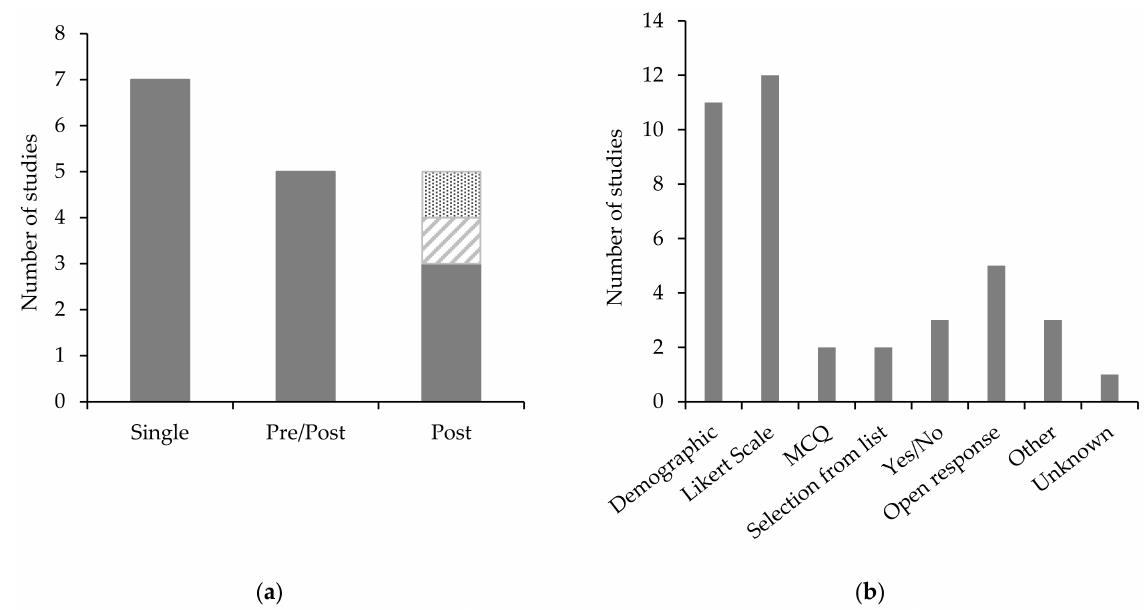
Figure 2. Summary of study methodologies: ( a ) time of data collection including a single point in time (Single), pre- and post-surveys (Pre/Post) or post-intervention (Post) and method of collection including survey (dark grey), focus group (diagonal stripe) or interview (dotted); ( b ) question styles utilised in surveys (MCQ: Multiple choice question. Other: Fill-in-the-blank, rating,